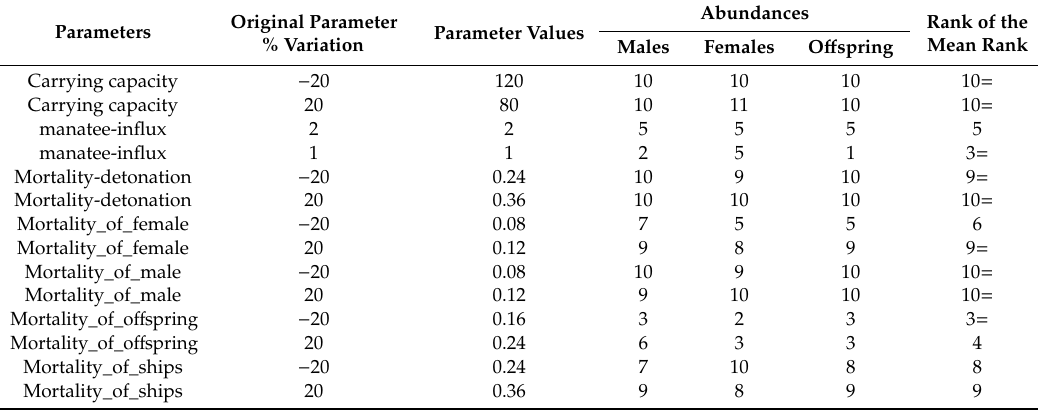
Table 1. Overall ranks of the parameters that showed sensitivity to changes on ± 20% for abundance per sex and life stage. Due to the nature of the manatee-influx parameter, units are the number of individuals, and changes cannot be less than zero or fractional. The “ = ” indicates a tie in rank.